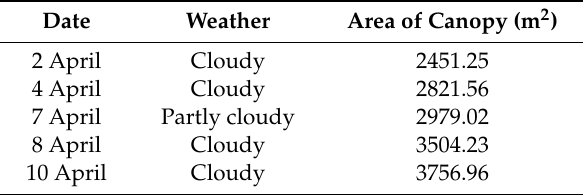
Table 3. The changes of canopy area and weather in the sakura region from 2 April to 1 May